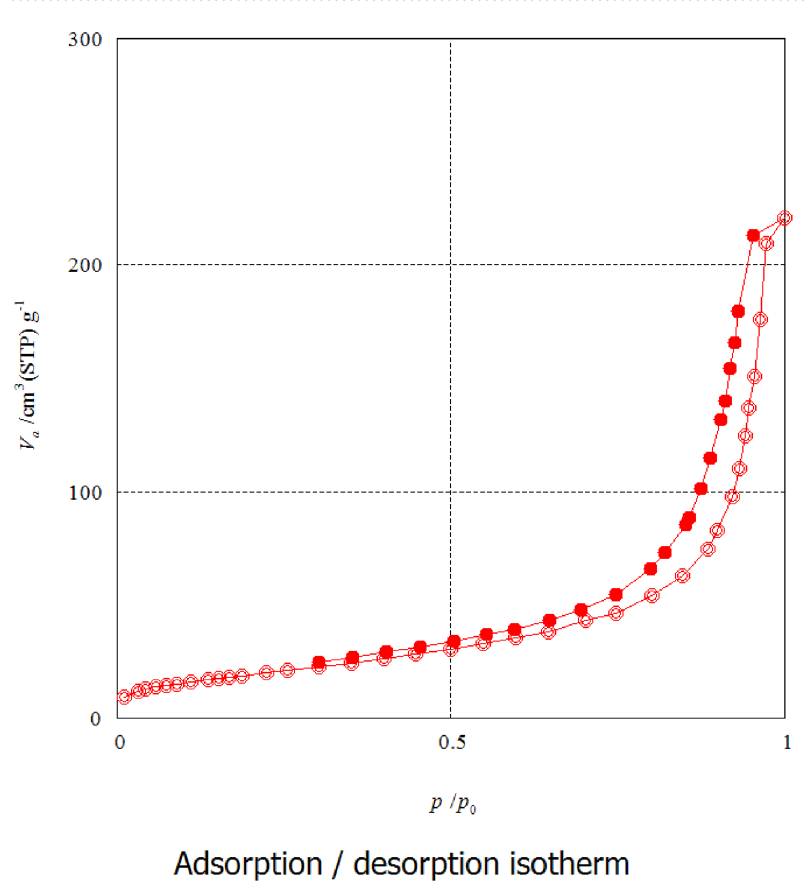
Figure 8. N 2 adsorption/desorption isotherm of the prepared (Z3C1)